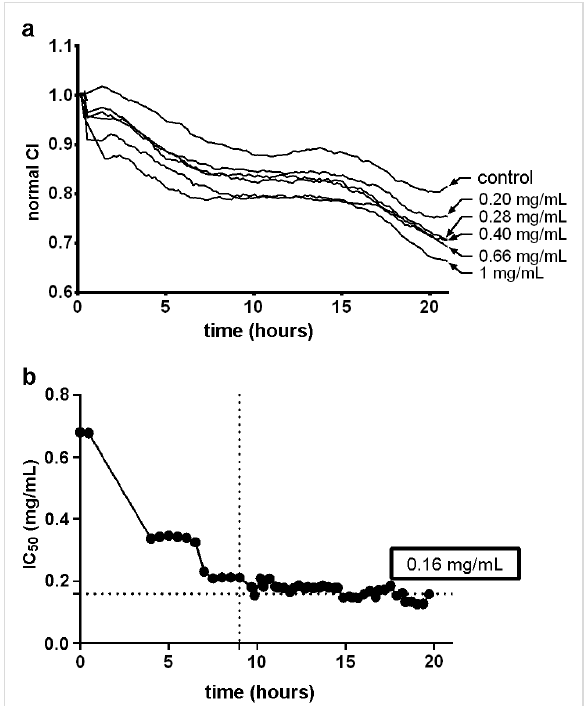
Figure 4: Ocular cytotoxicity studies of fluconazole in primary corneal human keratocytes obtained using real-time xCELLigence impedance analysis. (a) Kinetic curve survival rates; (b) evolution of IC 50 vs time.